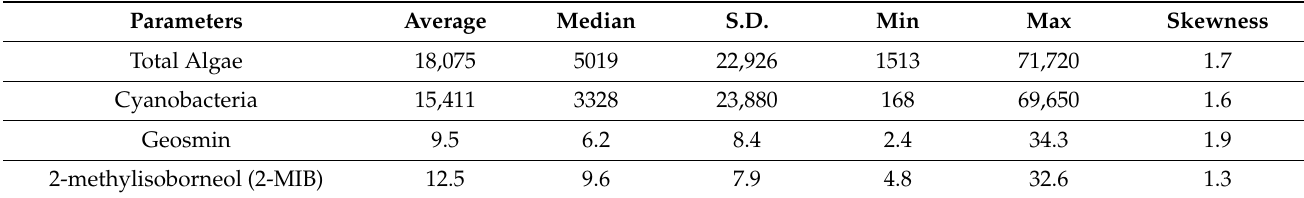
Table 3. The statistical data of total algae, cyanobacteria, geosmin, and 2-MIB in intake water. Parameters Average Median S.D. Min Max Total Algae